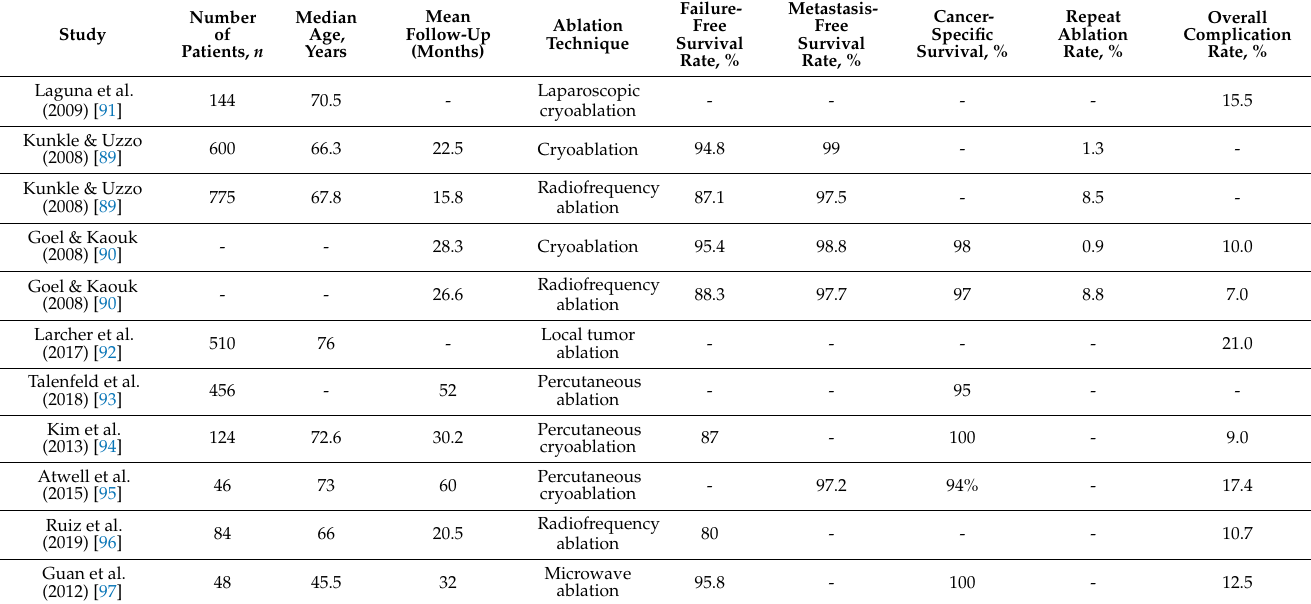
Table 2. Oncological and operative outcomes of focal therapy for the treatment of renal